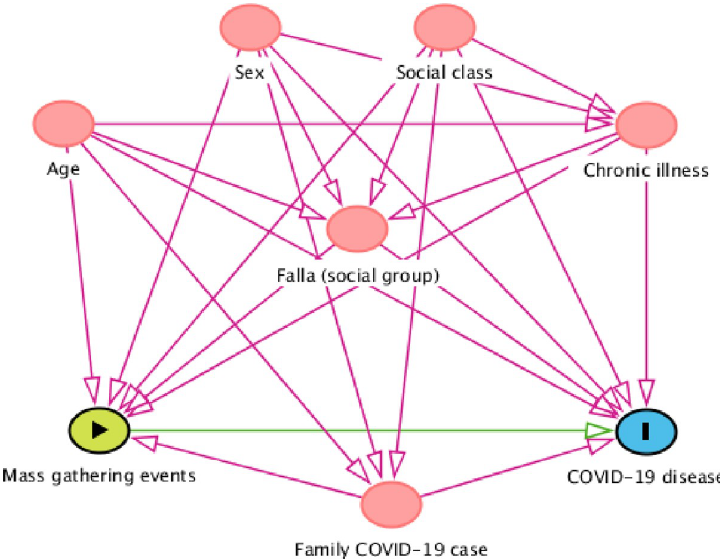
Fig 3. Directed Acyclic Graphs (DAG) of mass gathering events (exposure) effect on COVID-19 disease (outcome). Ancestors of exposure and outcome (in red). Based on DAGitty version 3.0.